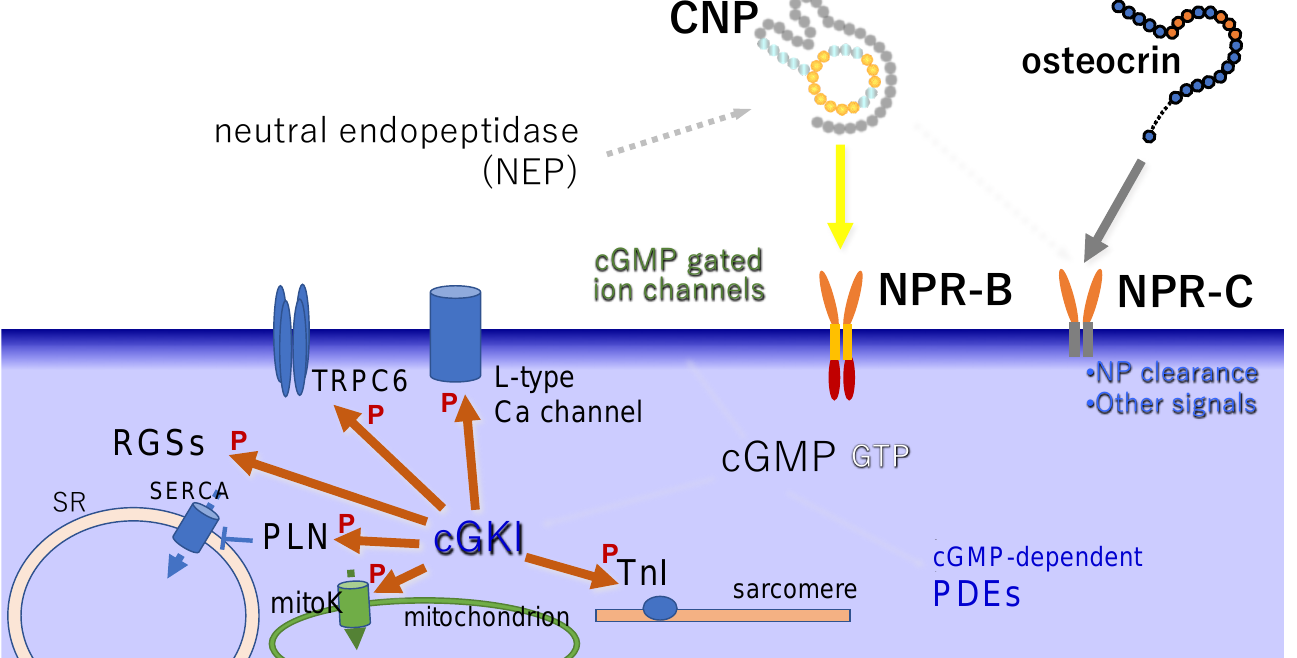
Figure 2. Schema of intracellular signaling molecules downstream of CNP/NPR-B. ‘P’ indicates the action of phosphorylation. SR: sarcoplasmic reticulum, SERCA: SR Ca-ATPase, PLN: phospholamban, RGS: regulator of G-protein signaling, TRPC6: transient potential canonical 6, TnI: troponin I, cGKI: cyclic GMP-dependent protein kinase I, mitoK: mitochondrial ATP-sensitive K channels and Ca-activated K channels of the BK type, PDE: phosphodiesterase.